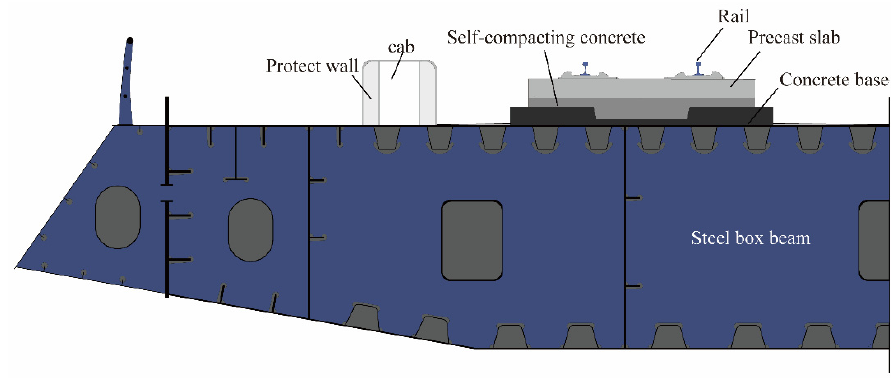
Figure 1. A concrete slab track on a steel box girder section.